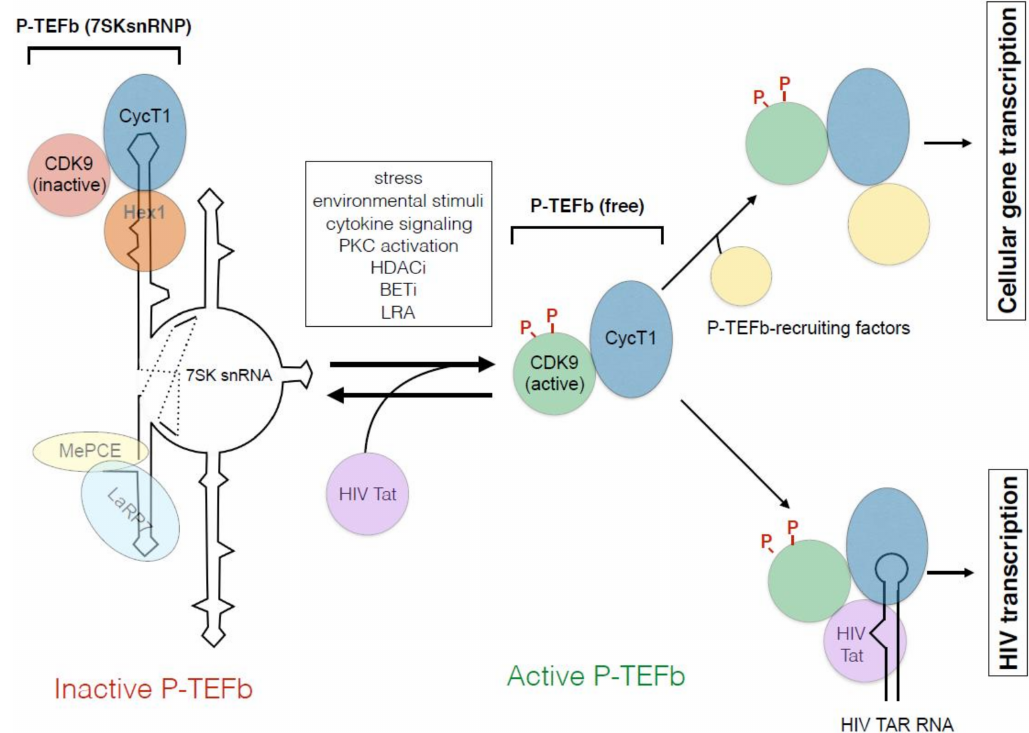
Figure 3. P-TEFb regulatory mechanism. In cells, most P-TEFb molecules are incorporated into 7SK snRNP, which contains 7SK snRNA, HEXIM1, MePCE, and LARP7. In 7SK snRNP, the CycT1 subunit directly binds to the central loop of 7SK snRNA and HEXIM1, which inhibits the kinase activity of Cdk9. Various stimuli, including stress, environmental stimuli, cytokine signaling, PKC activation, and treatment of cells with HDACis, BETis, and other LRAs, release P-TEFb and stimulate Cdk9 kinase activities accompanied by phosphprylation of critical T-loop (Thr 186) and central serine (Ser 175) residues. Released (free) P-TEFb can subsequently be recruited to RNAPII early elongation complex paused at promoter proximal regions of many cellular genes by various factors such as transcription factor, Brd4, Super Elongation Complex, Mediator complex, etc. HIV Tat protein can directly recruit P-TEFb to RNAPII on HIV LTR via binding with viral TAR RNA, since it can complete with HEXIM1/7SK snRNA for